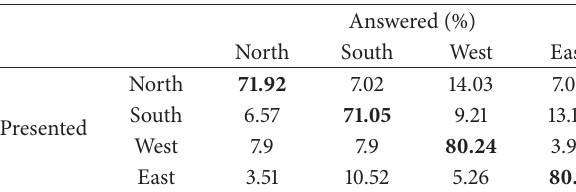
Table 1: Direction recognition rates with prototype